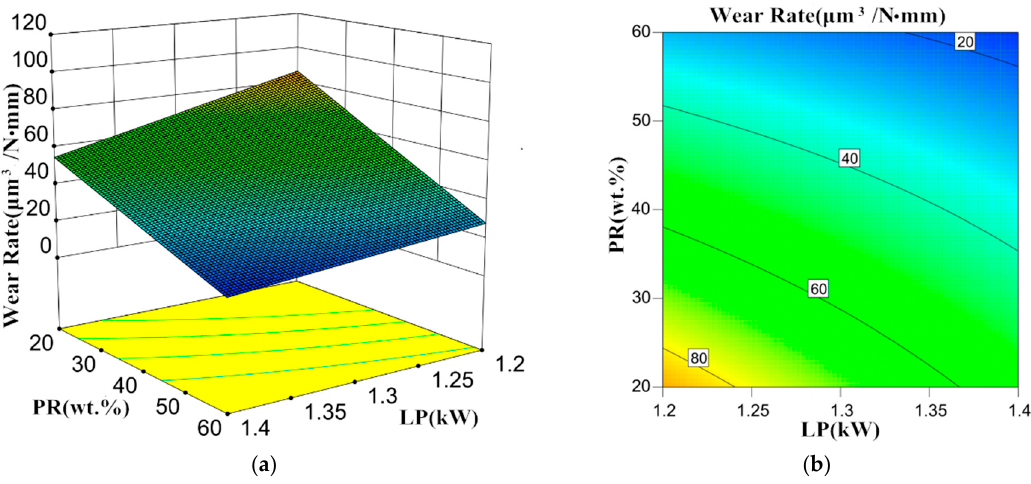
Figure 4. The response of wear rate to significant factors LP and PR . ( a ) 3D response surface; ( b ) contour plot.